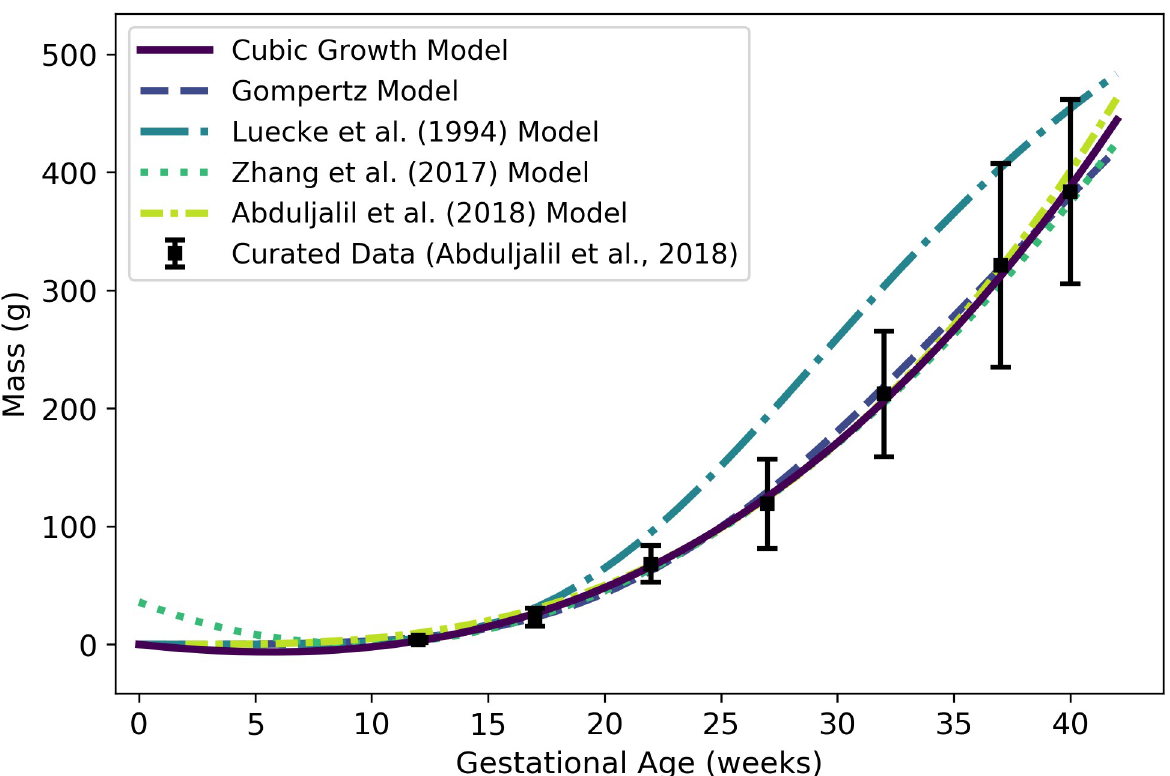
Fig 15. Fetal brain mass vs. gestational age. The quadratic growth model (solid line) given by Eq 28 was selected as the most parsimonious model in our analysis; however, that model gives negative brain mass values during early gestation. The Gompertz model (dashed line) given by Eq 29 is strictly positive on the time domain of interest. The model of Luecke et al. [15], which is a power law model based on fetal mass, was calibrated using a different data set [25]. The model of Zhang et al. [32] was also calibrated using a distinct compiled data set. The Zhang et al. [32] model describes brain volume, so the units were converted assuming a tissue density of 1